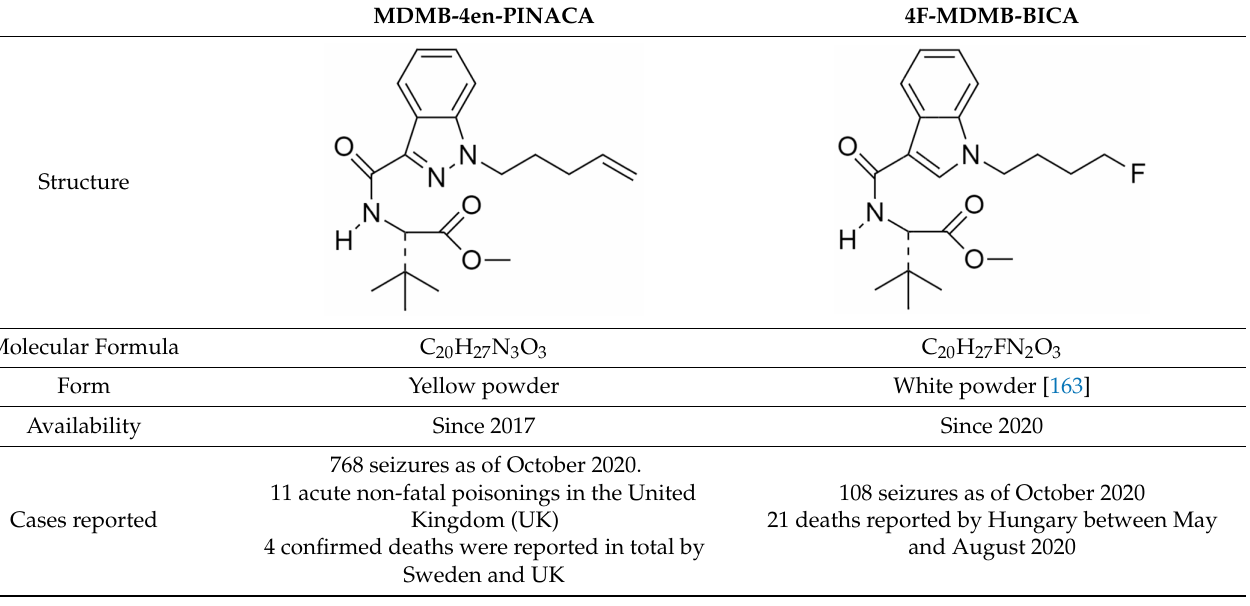
Table 3. Two synthetic CBs MDMB-4en-PINACA and 4F-MDMB-BICA concerning EU. Reprinted from ref [160].